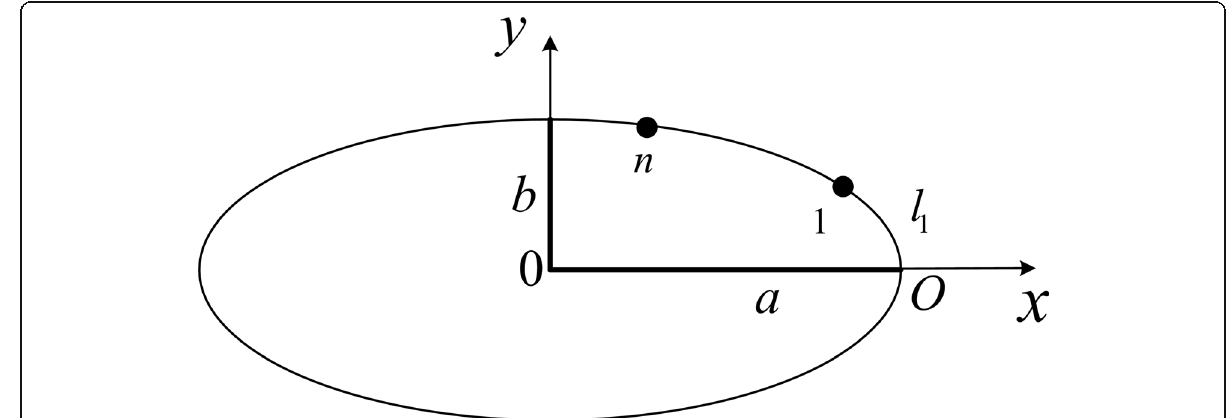
Fig. 2 Elements distribution of elliptical antenna